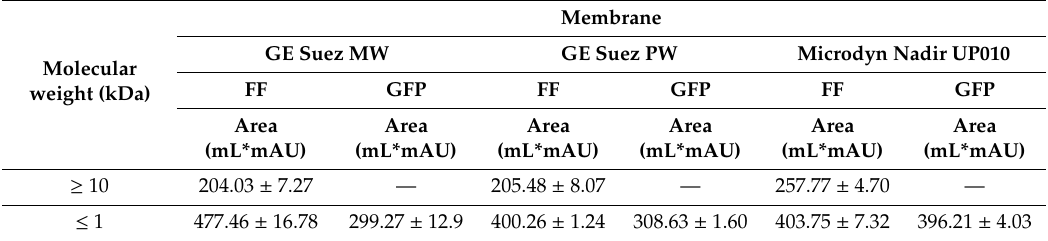
Table 5. FPLC chromatogram areas of the peaks from the retentates and permeates of pre-treated codfish obtained from di ff erent membranes. Results are given in